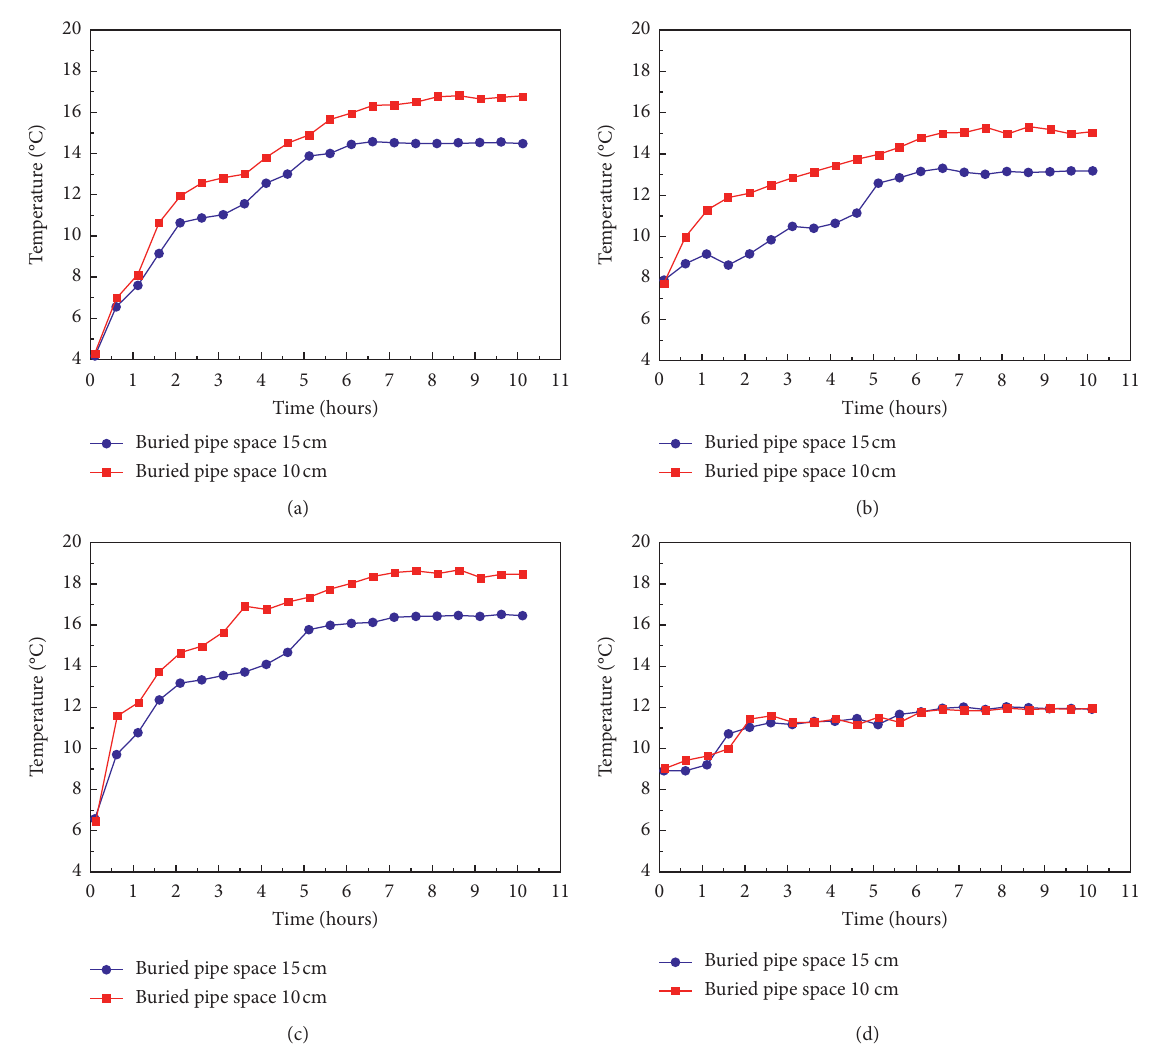
Figure 8: Temperature change curves of the measuring points of each layer under different space conditions: (a) the first layer; (b) the second layer; (c) the third layer; (d) the fourth layer.